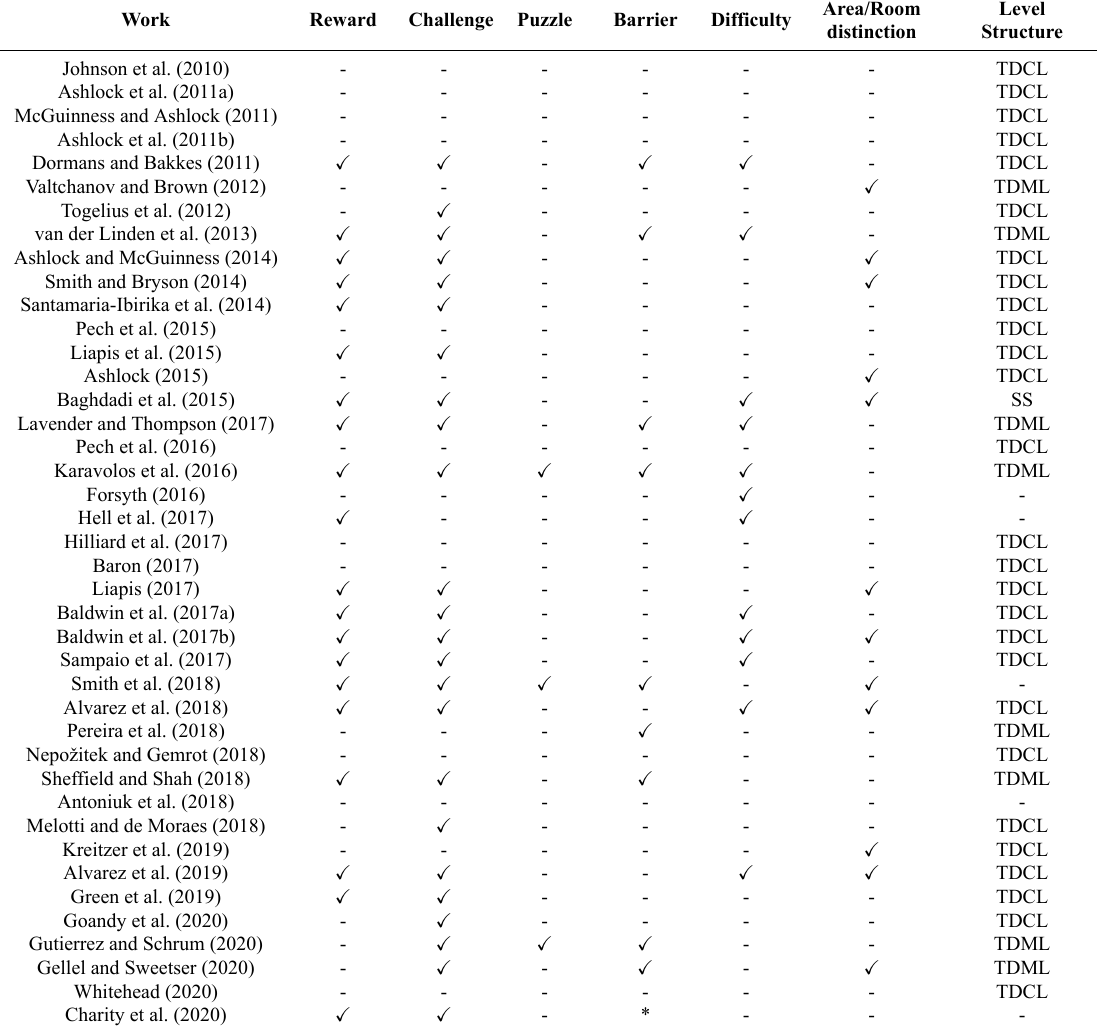
Area/Room Level distinction Structure